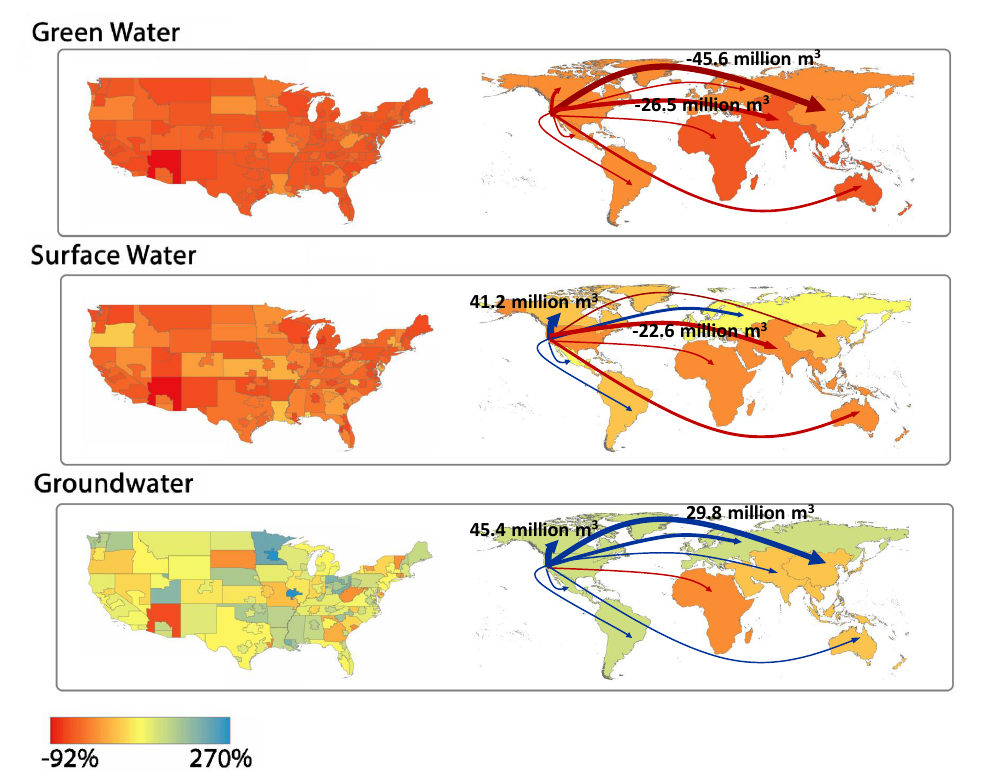
Figure 3. Percent change (%) in virtual water transfers from the California Central Valley to other areas of the United States and the world from 2011 to 2014. Green, surface, and groundwater virtual water transfers are shown. Note that green and surface virtual water transfers predominantly decrease, while groundwater transfers mostly increase, due to increased reliance on irrigation from the Central Valley aquifer during drought. This figure is adapted from Marston et al. [34] and is for the period